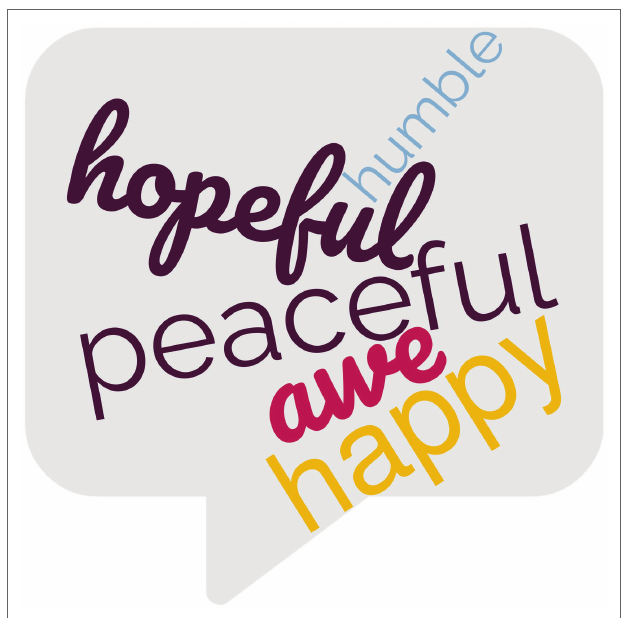
FIGURE 2 | Wordcloud graphic depicting emotion themes most likely to be associated with nature photos.